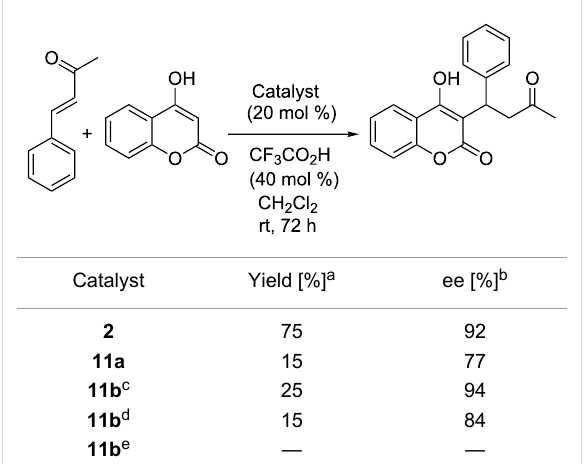
Table 2: Polymer-supported primary amine Cinchona organocatalysts in asymmetric preparation of